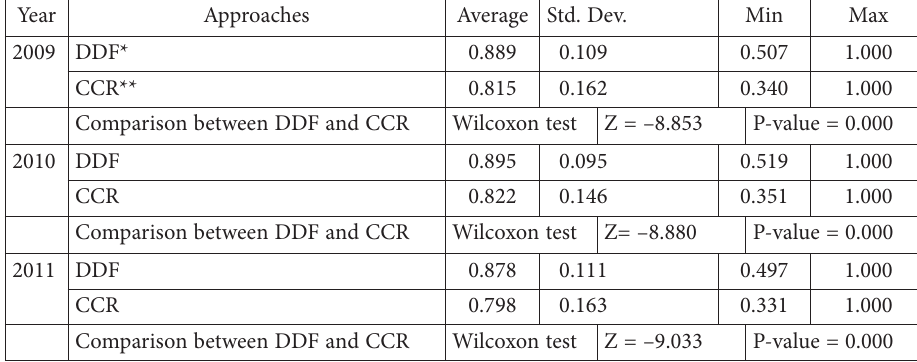
Table 5. Descriptive statistics of the metafrontier efficiencies for both